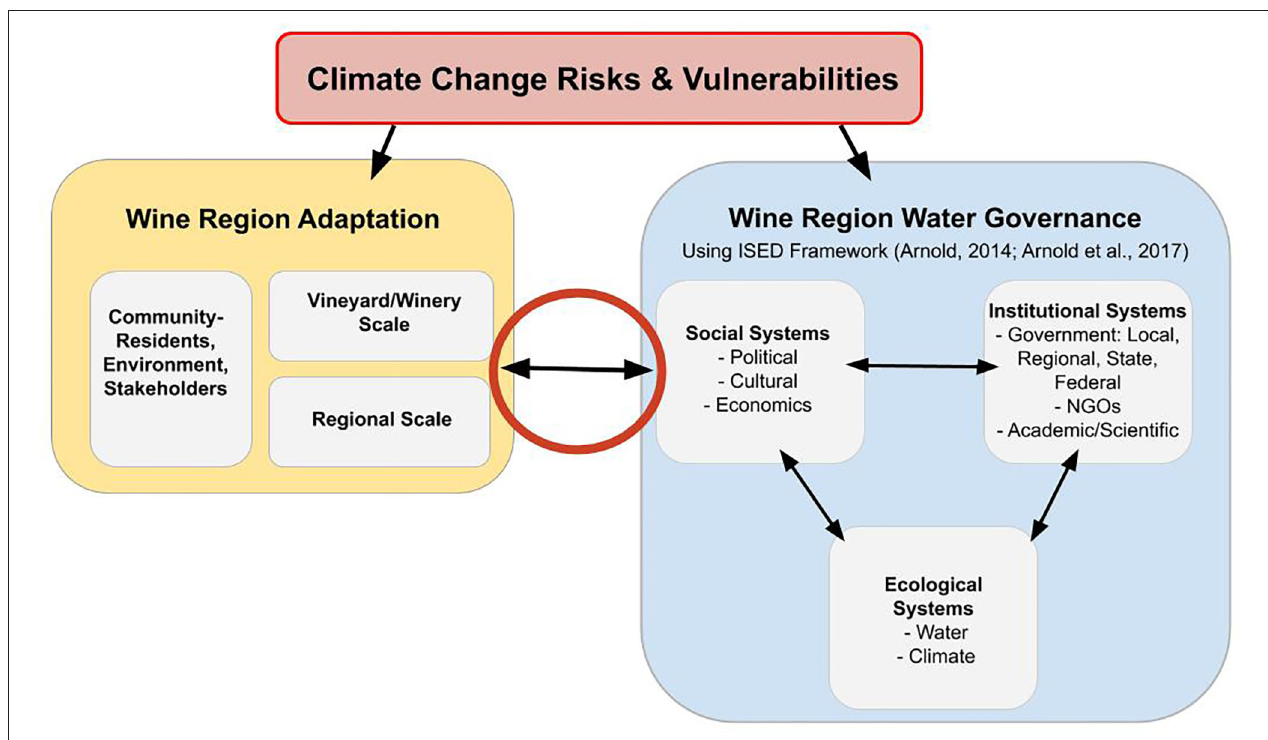
FIGURE 1 | Conceptual diagram using ISED framework approach-the relationship between wine region adaptation to climate change risks and vulnerabilities and water governance. Examples of institutional, social, and ecological systems as identified in the case